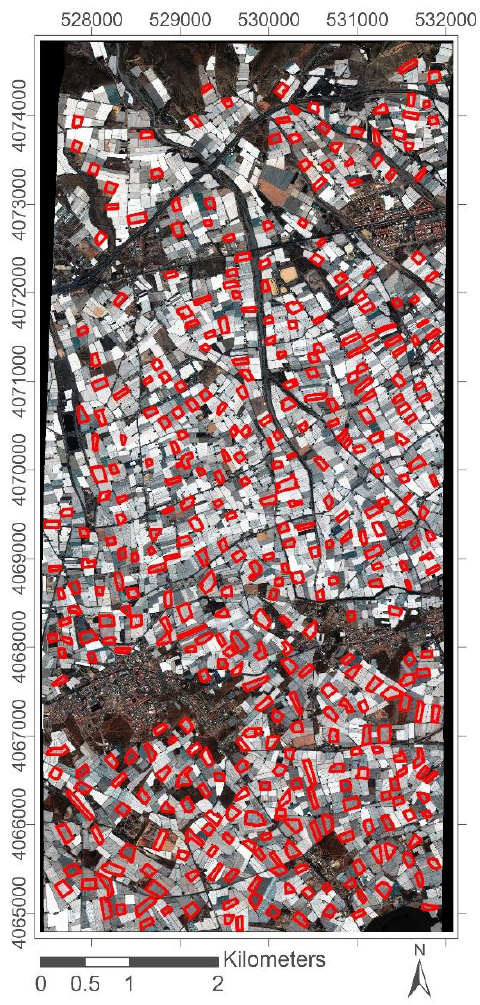
Figure 2 . 400 reference geometries manually digitized (polygons in red) representing PCG on the WV3 PANSH RGB